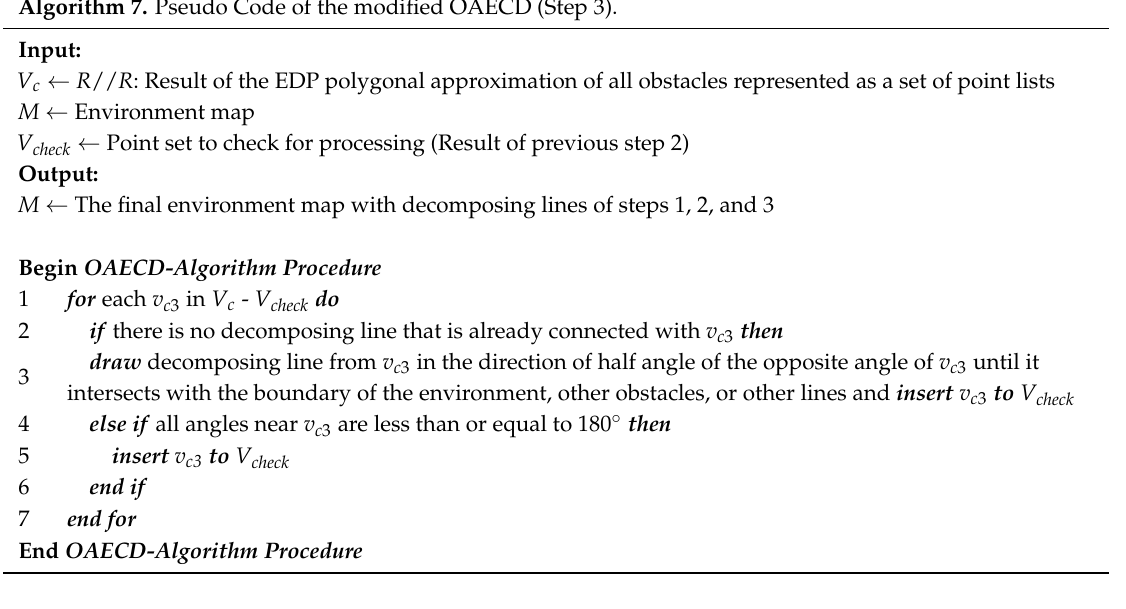
Algorithm 7. Pseudo Code of the modified OAECD (Step